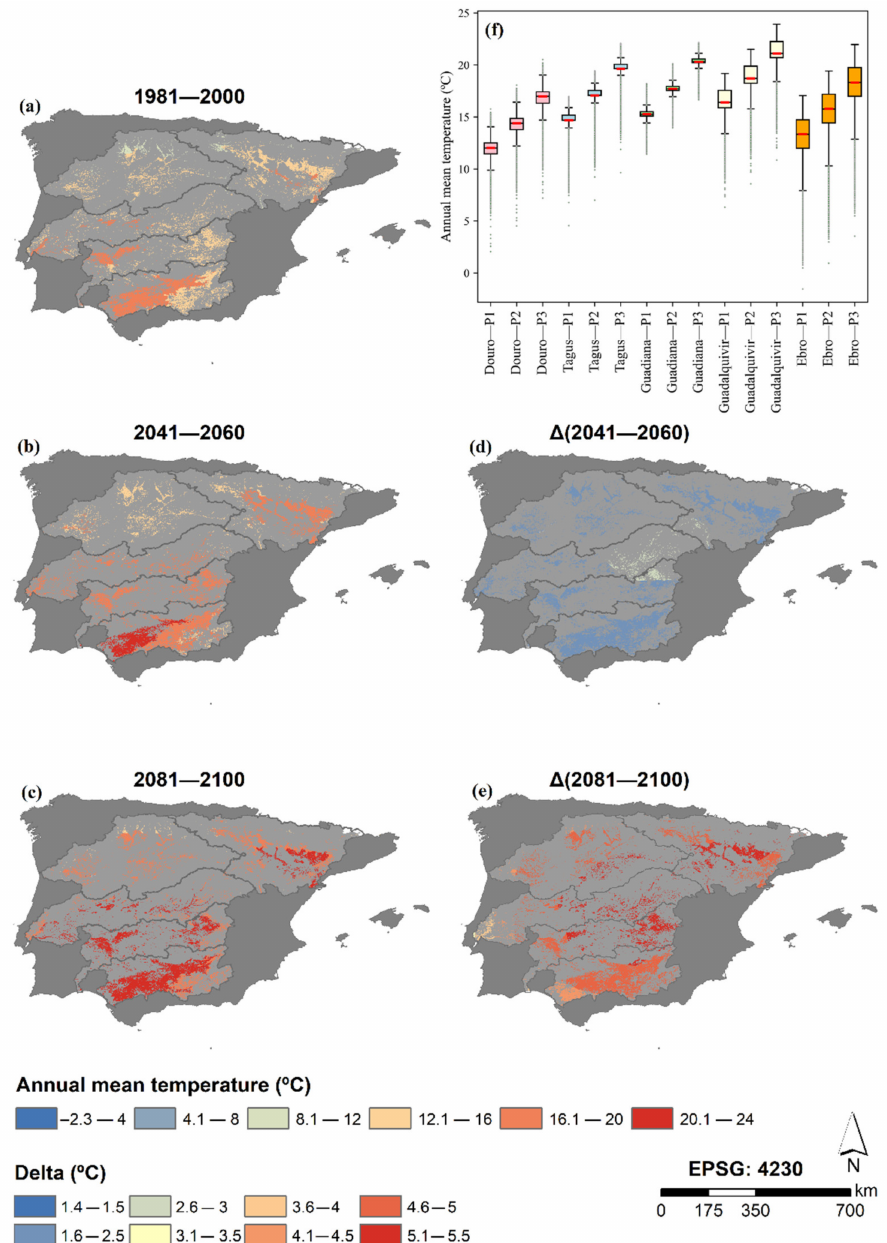
Figure 4. Annual mean temperature (in ◦ C) in water-dependent areas in the Iberian Peninsula for: ( a ) historical period 1981–2000 (P1), ( b ) 2041–2060 (P2), and ( c ) 2081–2100 (P3), ( d ) P2–P1, ( e ) P3–P1, and ( f ) locality, spread, and skewness for each period and river